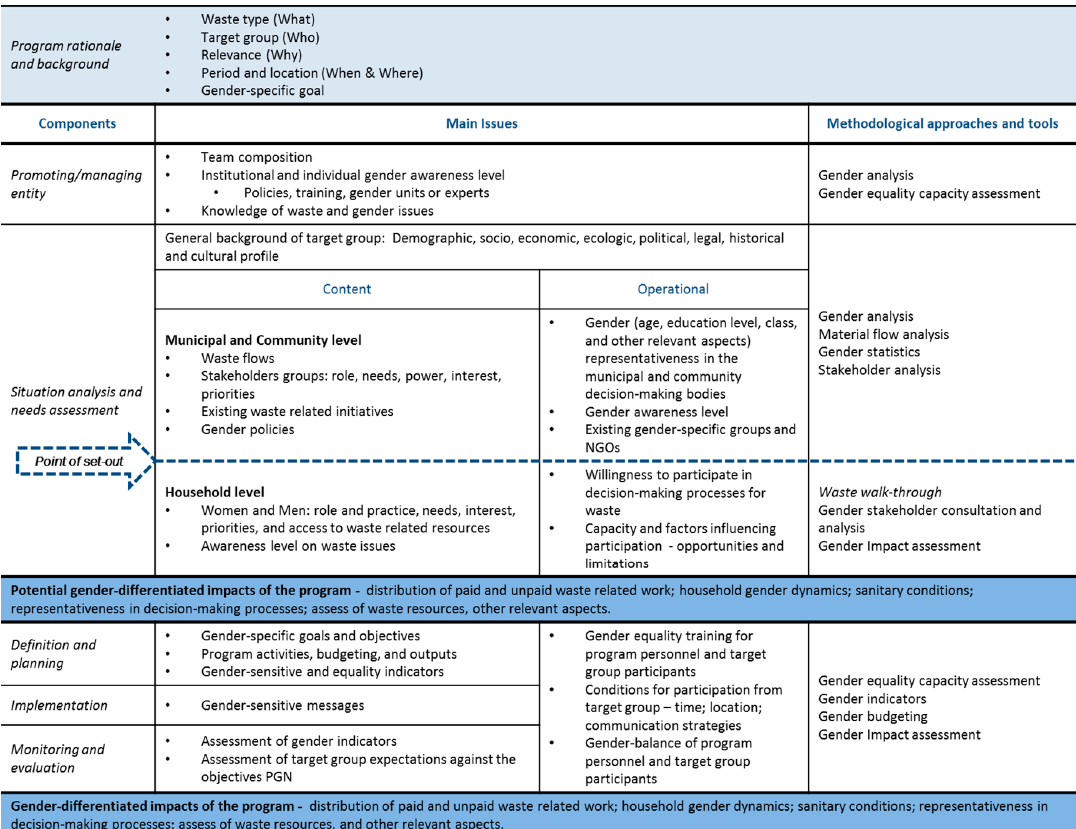
Figure 1. Framework for mainstreaming gender in waste education programs.